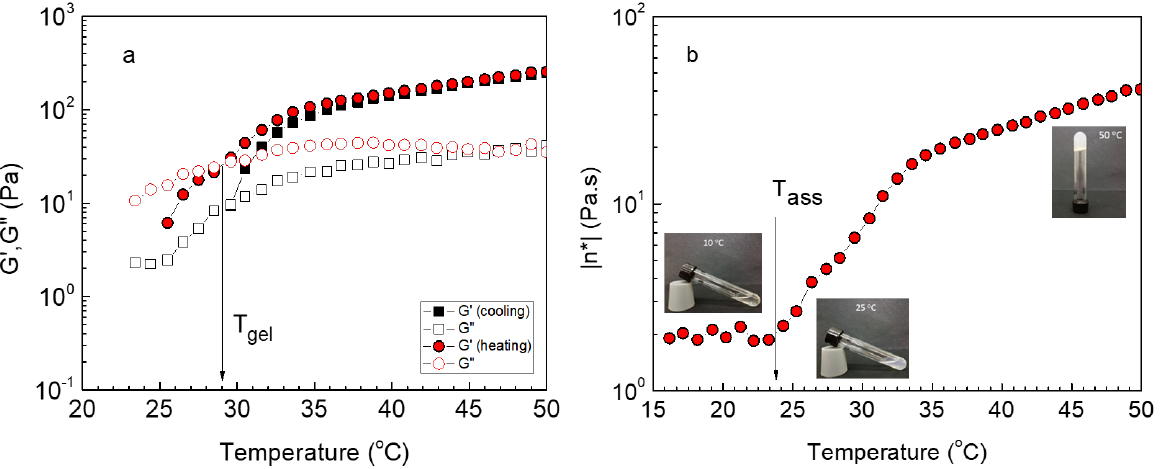
Figure 2. Temperature dependence of G’ (closed symbols), G” (open symbols) ( a ) and complex viscosity (heating) ( b ) at 1 Hz and strain amplitude of 0.1% for the ALG/HGC hydrogel with a cooling– heating ramp of 1 °C/min. The arrows indicate T gel in ( a ) and T ass in ( b ). The photos (inset of b ) depict the solutions at different temperatures, showing a transparent solution at 10 °C, a turbid solution at 25 °C, and a free-standing gel at 50 °C.